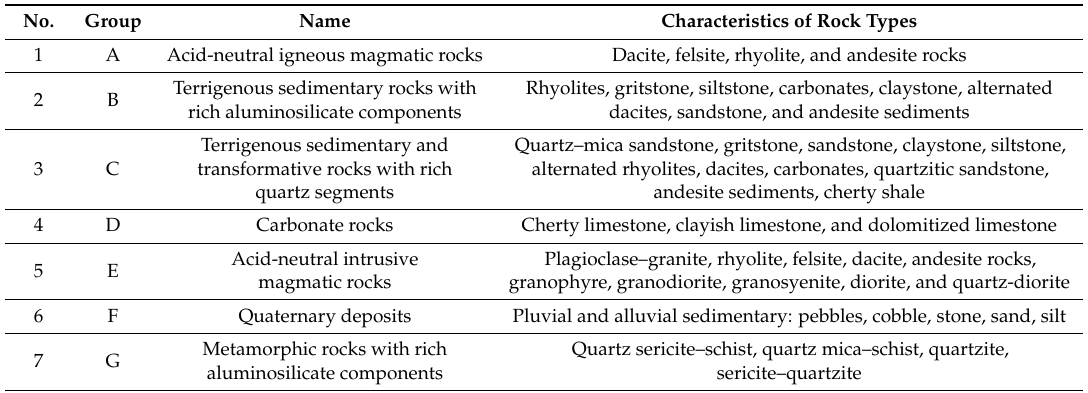
Table 3. Lithology groups and their